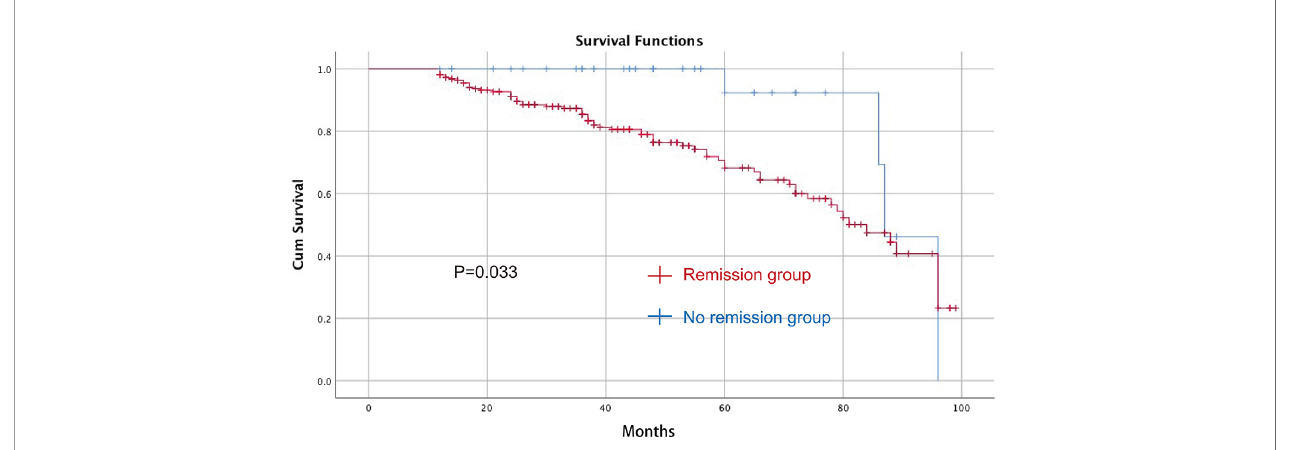
FIGURE 2 | The Kaplan – Meier curve between the T2DM remission group and the no remission group after CRC surgery for OS. CRC, colorectal cancer; T2DM, type 2 diabetes mellitus; OS, overall